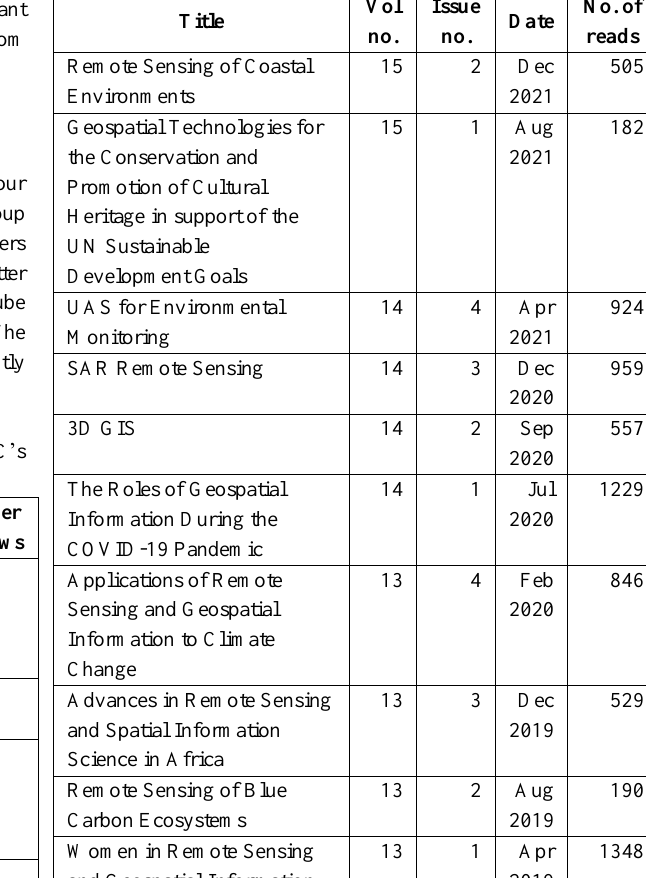
Table 2. The SpeCtrum issues published since 2017 and their corresponding number of